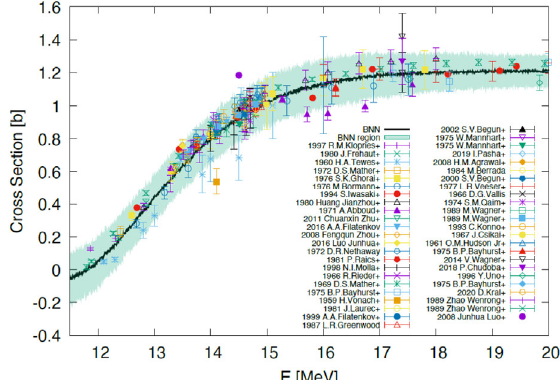
Fig. 2. The comparison of the obtained 89 Y(n,2n) cross sections and uncertainty and the relevant measurements.